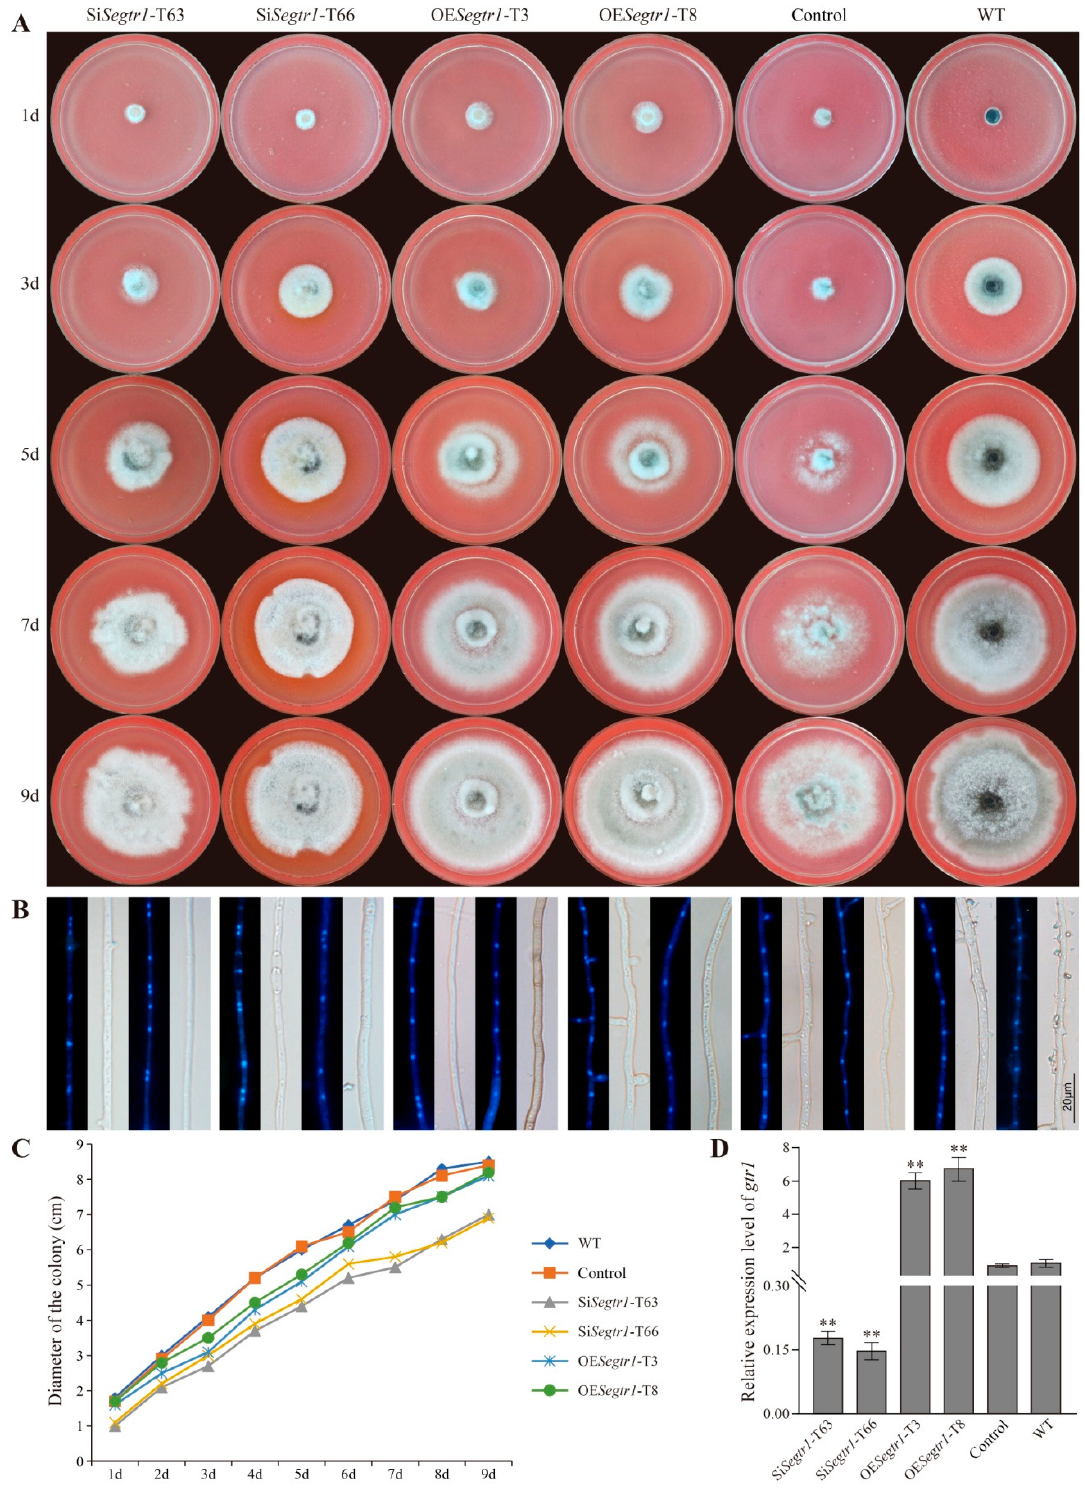
Figure 2. The colonial phenotypes and nuclear distribution of Segtr1 silenced transformants. ( A ) Colonial growth of two Segtr1 silenced transformants (Si Segtr1 -T63 and Si Segtr1 -T66) and two Segtr1 overexpression transformants (OE Segtr1 -T3 and OE Segtr1 -T8) was observed on PDA medium. WT was S. eturmiunum strain and Control was a negative control strain. The cultures were photographed after 1 day, 3 days, 5 days, 7 days and 9 days. ( B ) The mycelium of these four transformants were grown on PDA medium for 6 days and examined by DIC and fluorescence microscopy. The nuclei of the mycelia were discovered under the fluorescence microscopy after staining by DAPI. Bar = 20 μ m. ( C ) Colony diameters were measured in each independent biolog-